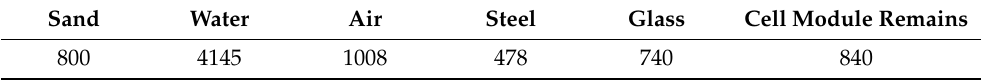
Table 2. Values of specific heat of substances present in the measuring block in (J/(kg*K).